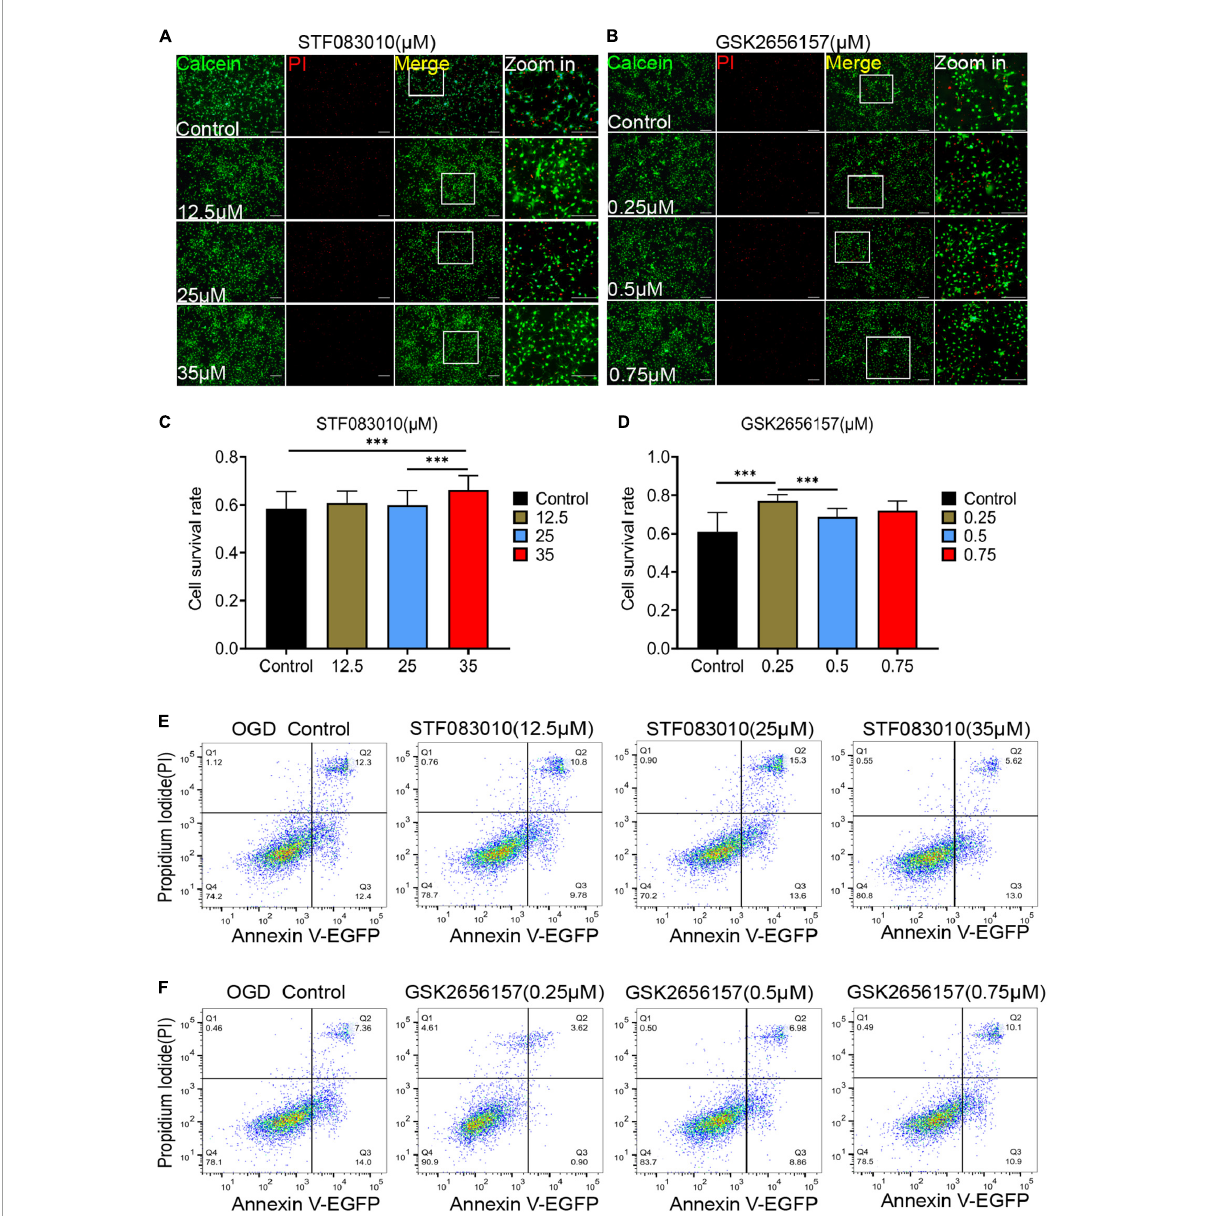
FIGURE6 Endoplasmic reticulum stress (ER) stress inhibition protect OPCs from death after OGD stimulation. (A,B) The effects of different concentrations of STF083010 and GSK2656157 on OPCs mortality after OGD stimulation by Calcein AM/PI double staining. Scale bars had been indicated in pictures. n = 3 biological repeats. (C,D) The histograms revealed the statistical results of oligodendrocytes mortality after OGD stimulation. n = 3 biological repeats. Values are the mean ± SEM. Statistical significance was determined by one-way ANOVA followed by Student Newman–Keuls post-hoc test. ∗∗∗ P < 0.001. (E,F) Through flow cytometry of apoptosis by Annexin V-EGFP/PI double staining, the results revealed the roles of STF083010 and GSK2656157 in the death of OPCs. n = 3 biological